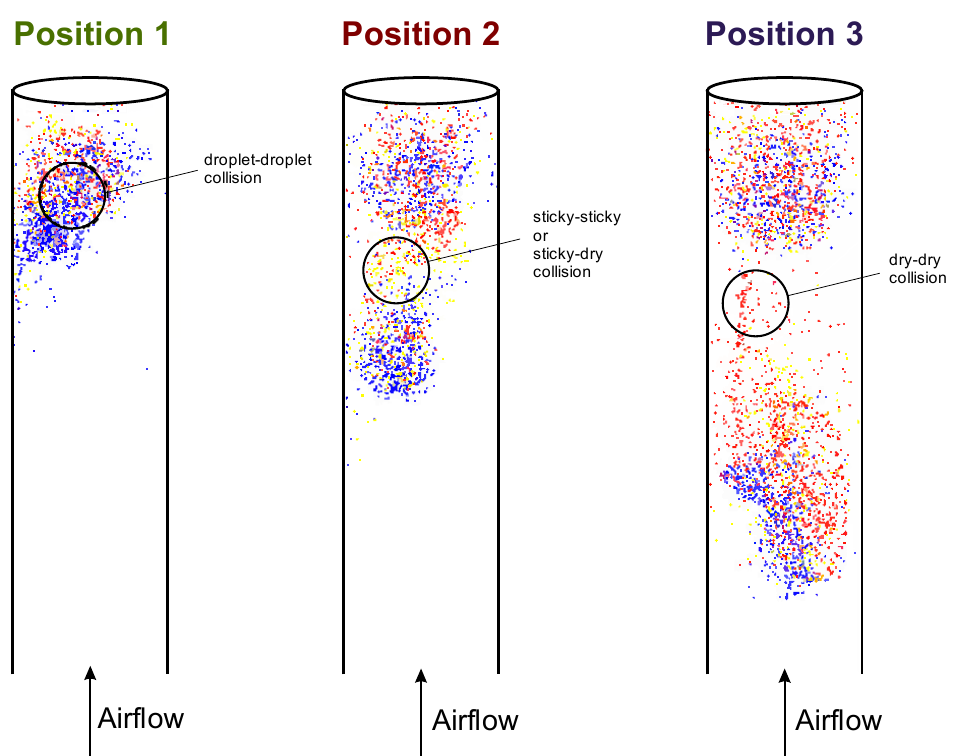
Figure 11. Location of droplet, sticky, and dry collision zones for different nozzle configurations (Position 1, 2, 3, Ref. [9]).